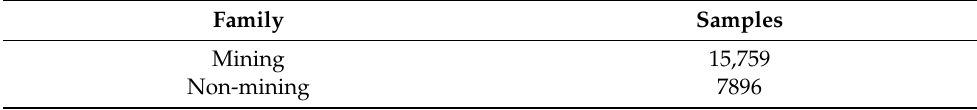
Table 3. Details of each malware family in the DataCon data set.